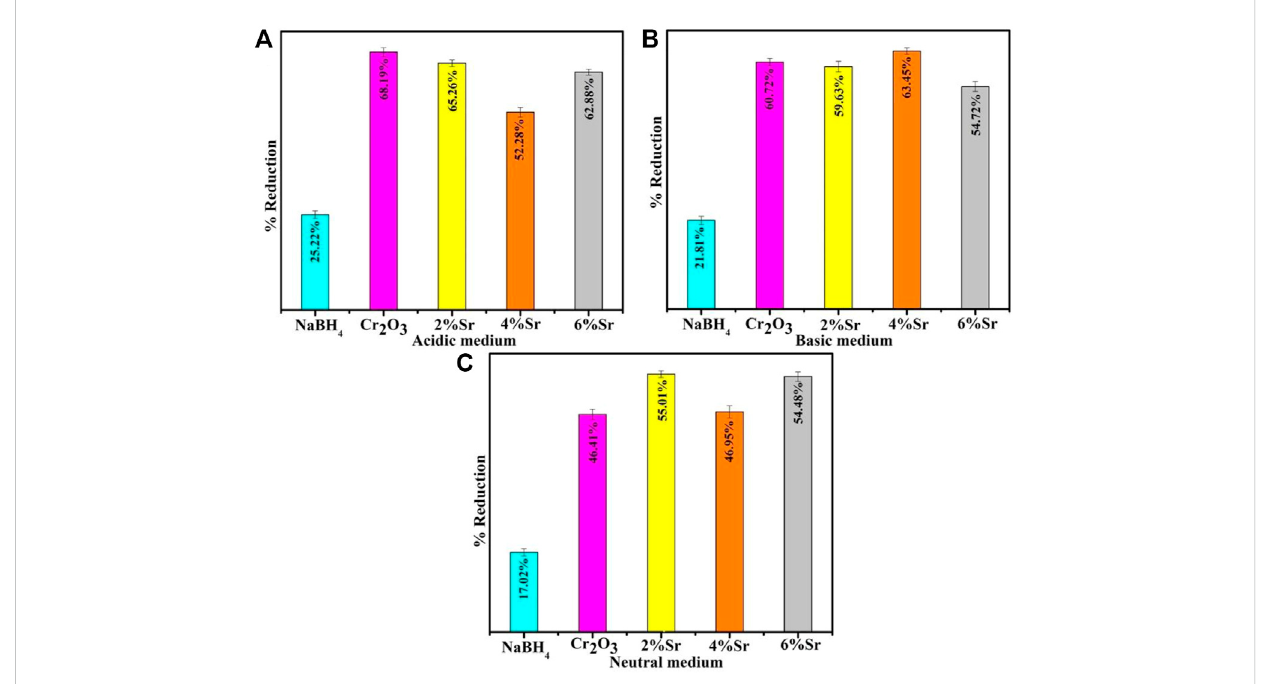
FIGURE 8 Catalytic activity of Cr 2 O 3 and Sr-doped Cr 2 O 3 in the presence of NaBH 4 . (A) Acidic Medium, (B) Basic Medium, (C) Neutral